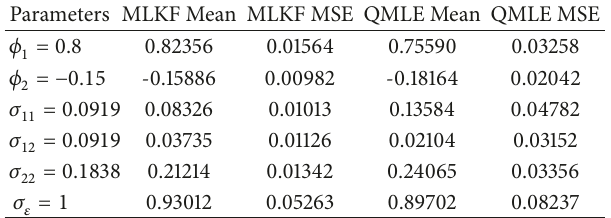
Table 3: Mean and MSE of estimated parameters for Example 2; 𝑛 = 100 .